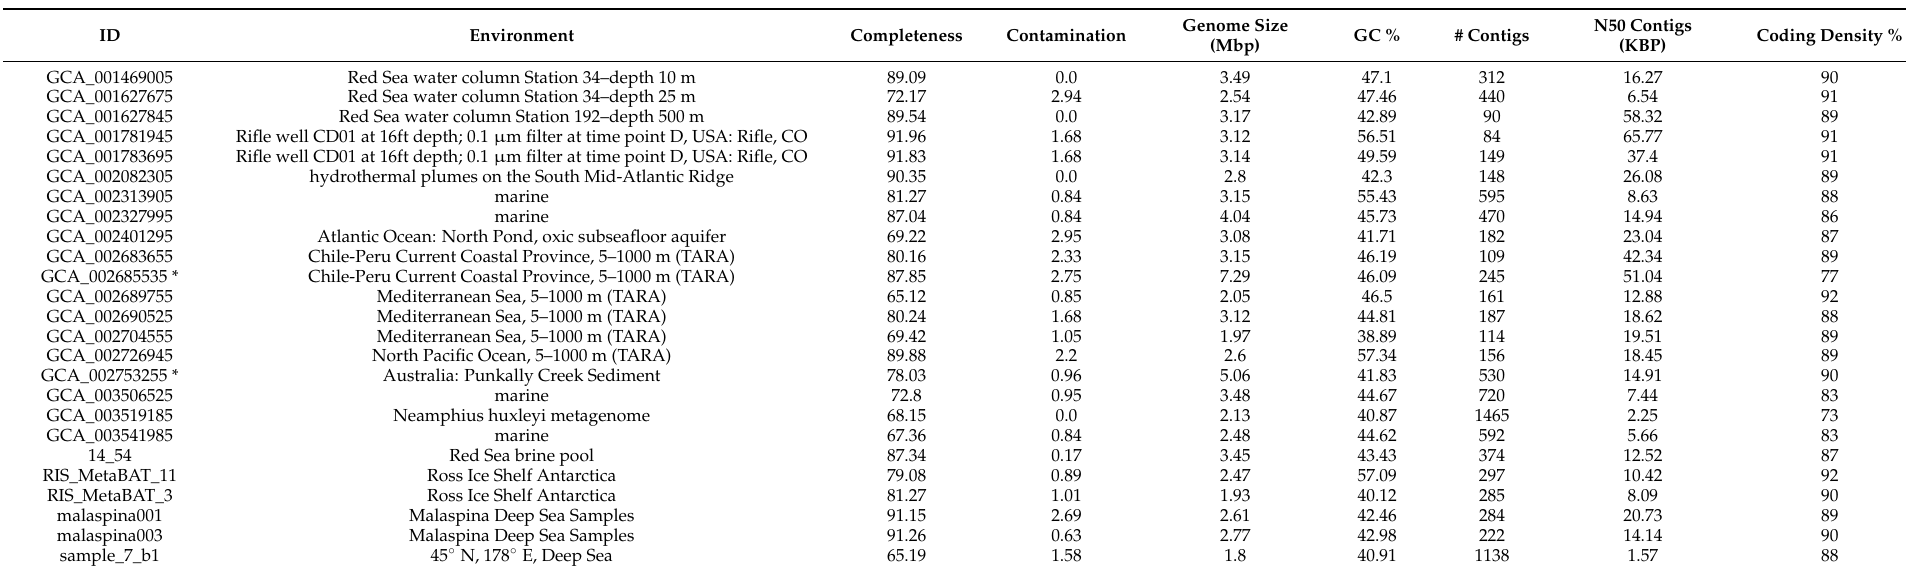
Table 1. Genome properties of all the genomes which passed our quality filtering and de-replication (see Material and Methods for details). All genomes are ordered according to their completeness values. * An asterisk next to a genome name indicates a bin containing more than one copy of the genome. # In the columns is an abbreviation for “Numbers of”. The origin of genomes which did not pass our quality filters is shown in Supplementary Table